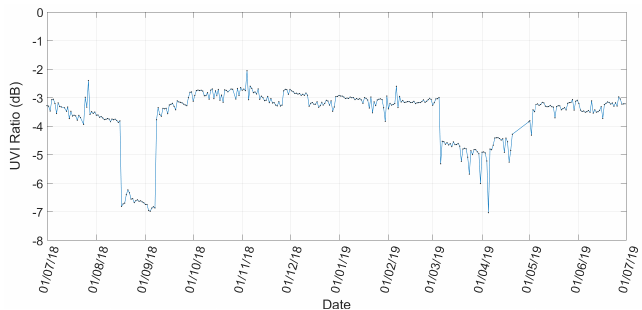
Figure 9. UVI ratio (UVI inside the greenhouse / UVI outside) in